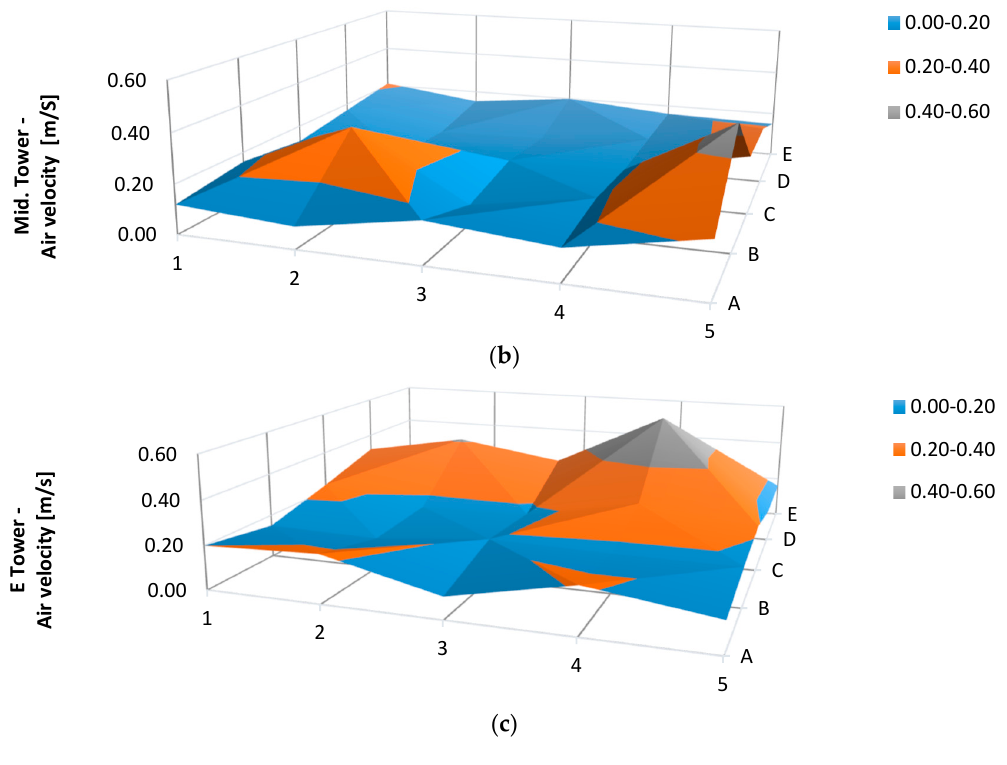
Figure 13. Manual measurement results in 25 sampling points per each tower about air velocity in the bottom inlets in 3 m height.